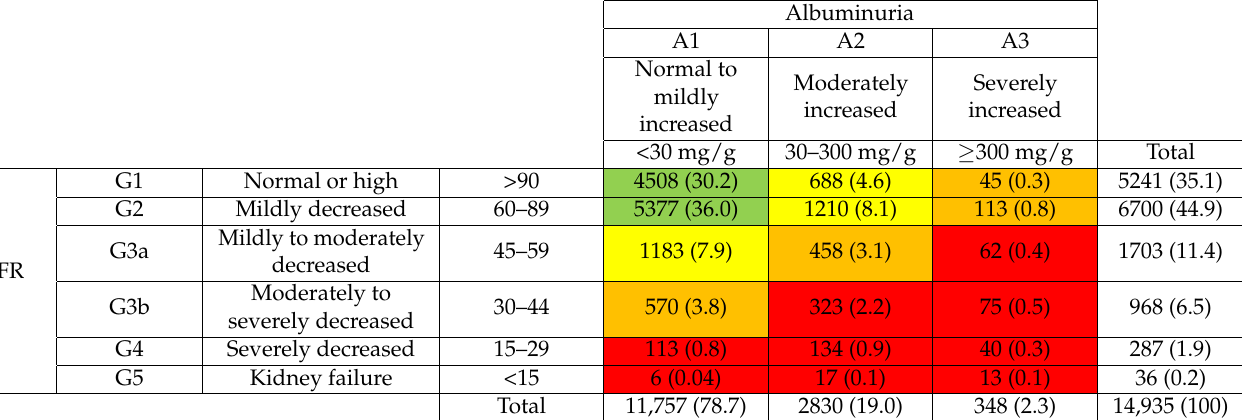
Table 2. Distribution of the 14,935 patients according to eGFR and albuminuria categories according to the KDIGO 2012 CKD classification. Field coloring indicates risk of CKD: green, low risk; yellow: moderately increased risk; orange: high risk; red: very high risk [30].